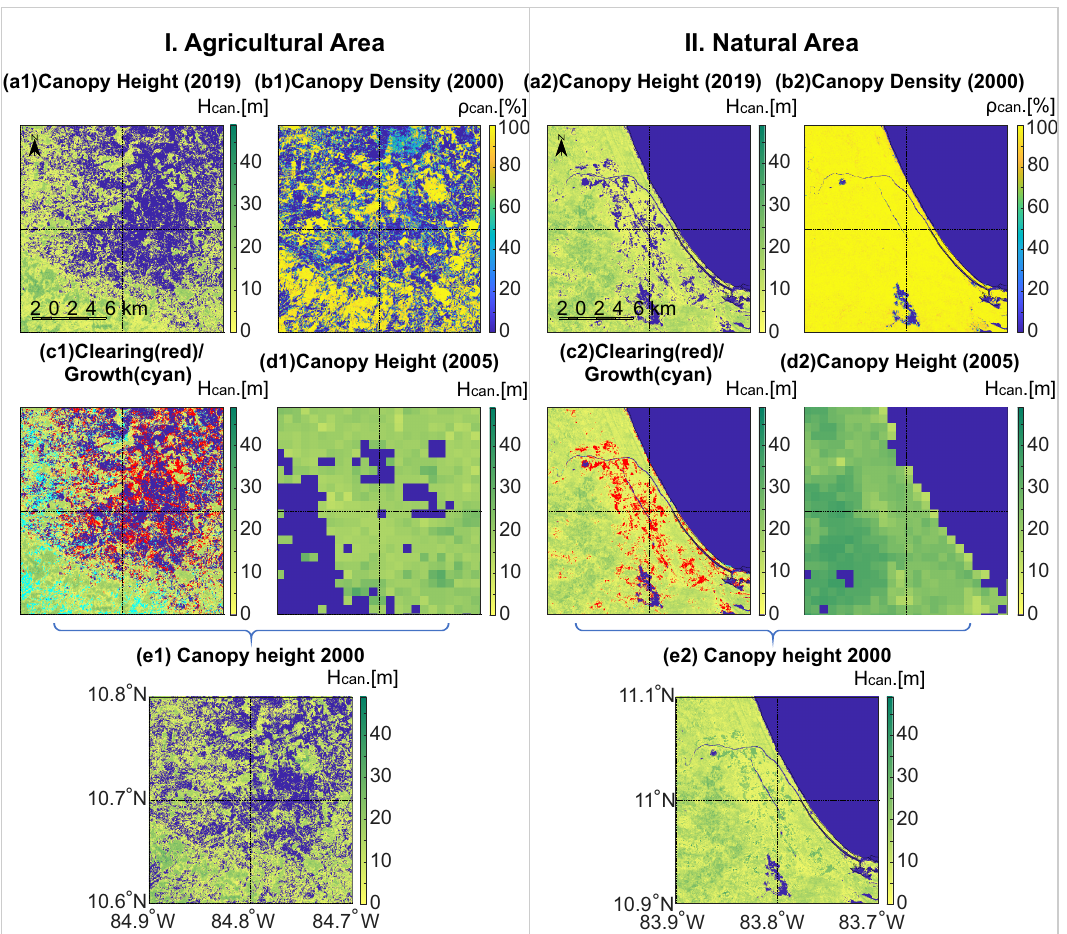
Figure 7. Steps in preparation of the model of Canopy Height Model for 2000 (CHM2000) for two example areas in ( I ) the agricultural zone in Alajuela and ( II ) the natural area in Tortuguero. ( a ) GFCH2019 Model. ( b ) Canopy density for the year 2000 from the Global Forest Change Model. ( c ) Cells identified as canopy clearing (in red) and growth (in cyan) plotted above the canopy height map presented in ( a ). ( d ) The 1km mesh size FCHM. ( e ) Computed